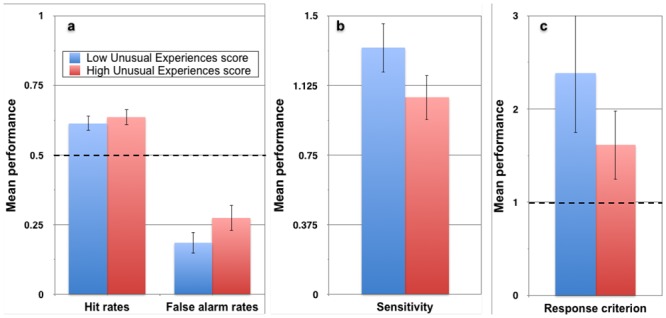
Mean performance on the Perception Of Meaning task in Experiment 2.Data shown separately for individuals scoring below and above the median on the UnEx subscale of the O-LIFE (N = 94, error bars represent ±95% confidence intervals). The reference line at 0.5 in panel a represents chance performance in the yes-no task, whereas the reference line at β = 1.0 in panel c represents the point of no response bias for an unbiased responder. A β value less than 1 indicates a bias toward saying a face was present in a noise-only stimulus.